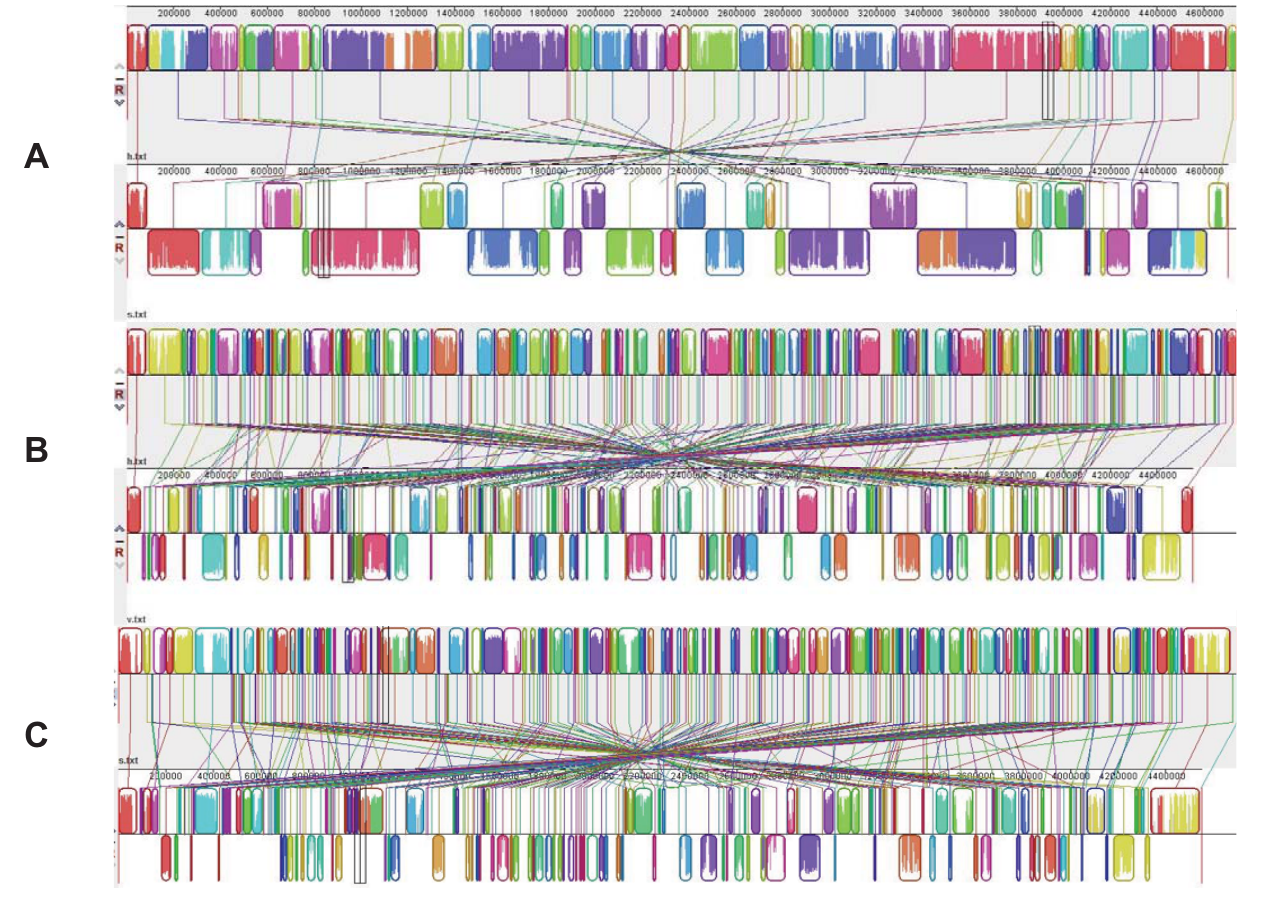
Figure 1. Gene alignment of genomes of A. hydrophila , A. salmonicida and A. veronii using MAUVE multiple alignments. Colored outlined blocks surround regions of the genome sequence that aligned to part of another genome. The colored bars inside the blocks are related to the level of sequence similarities. Lines link blocks with homology between two genomes. Genome pairs from top to bottom: ( A ) A. hydrophila/A. salmonicida ; ( B ) A. hydrophila/A. veronii ; ( C ) A. salmonicida / A.